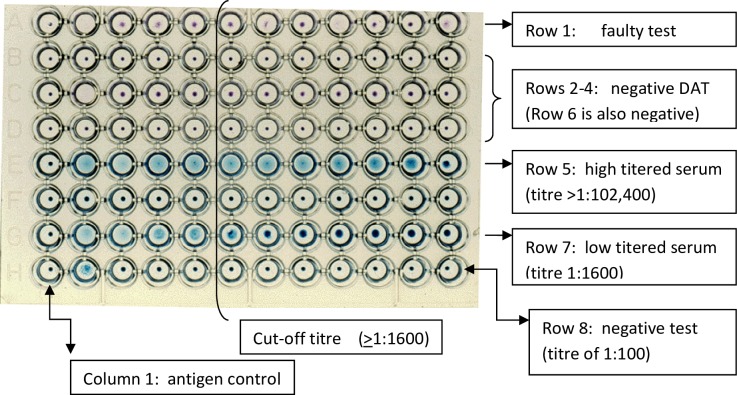
A plate showing DAT test results in sera tested with a starting dilution of 1:100 in column 2.